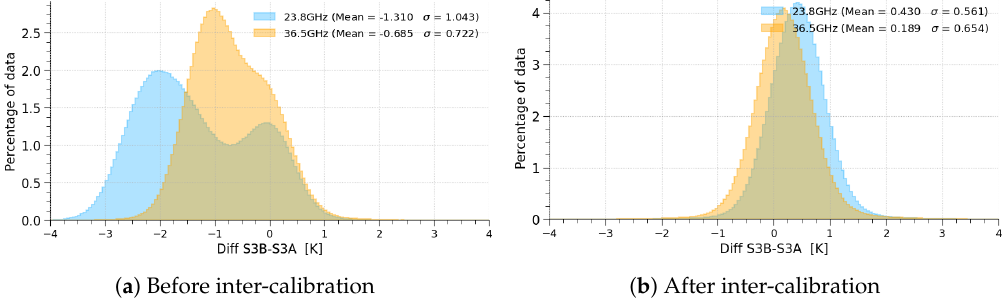
Figure 12. Histogram of Residual differences between S3A and S3B brightness temperatures ( a ) before and ( b ) after S3B inter-calibration for cycle 10 of S3B.